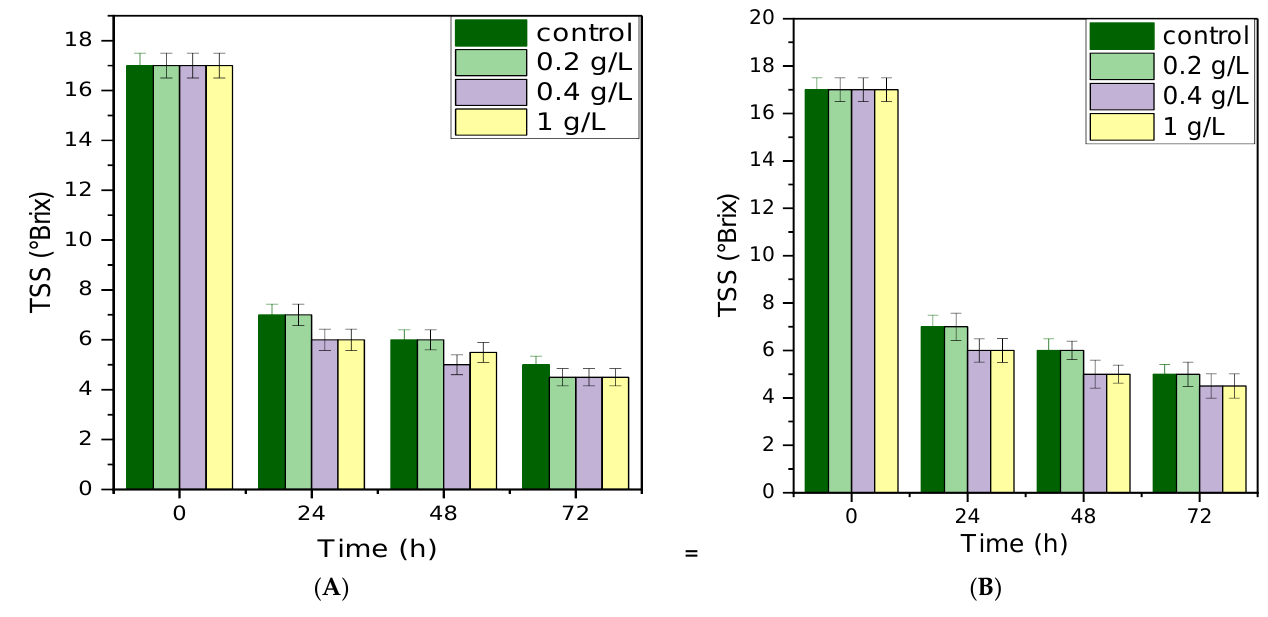
Figure 2. Evolution of total soluble solids (TSS) during anaerobic fermentation: ( A ) effect of CaCl 2 and ( B ) effect of CaCO 3 .